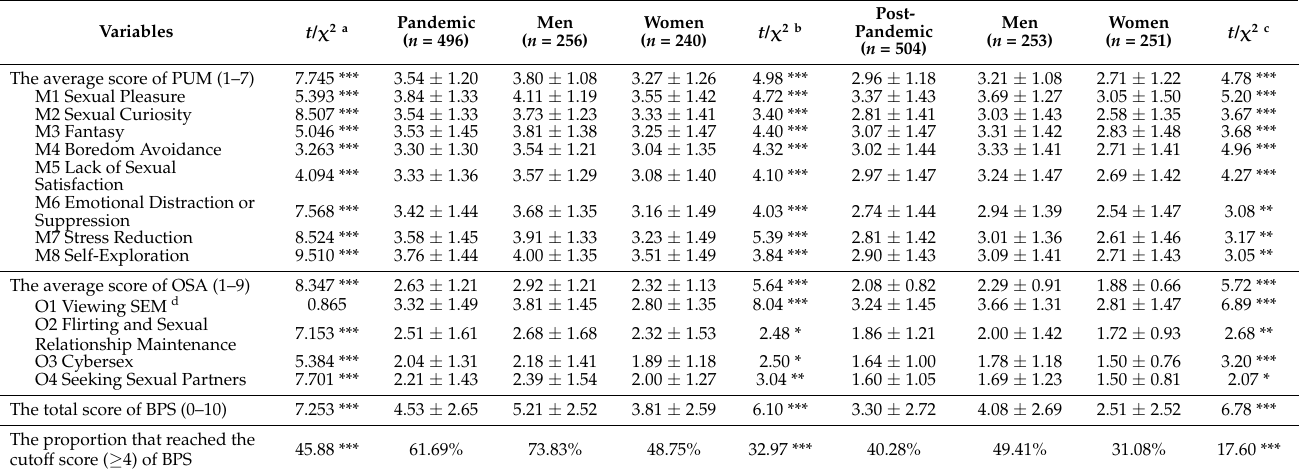
Table 2. Descriptive statistics and t -tests on measures of PUM, OSA, and BPS (Mean ±